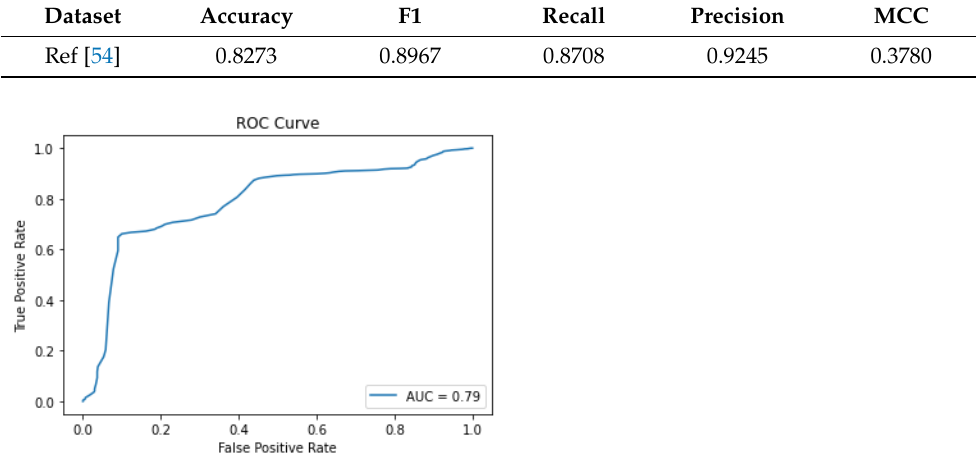
Table 5. Result of benchmark dataset with RF training/test using group 1 dataset.